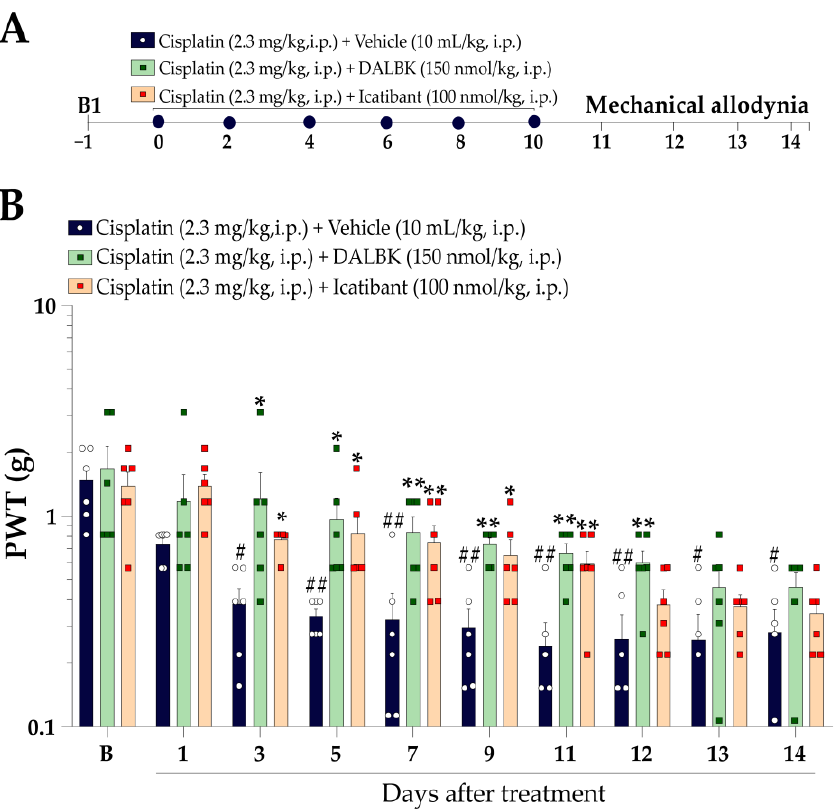
Figure 4. Preventive effect of kinin B 1 and B 2 receptor antagonists on cisplatin-induced mechanical allodynia. ( A ) Preventive protocol : Male Swiss mice were treated concomitantly by